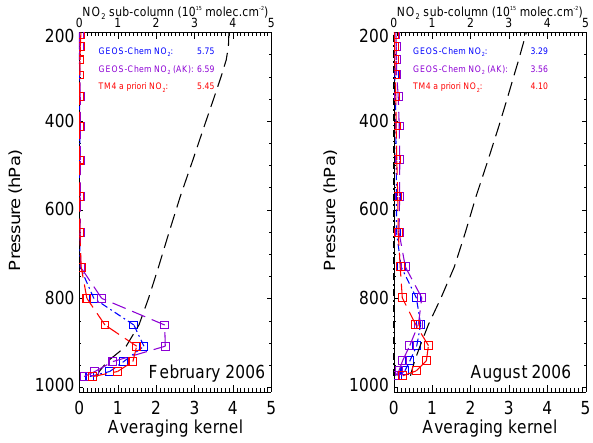
Figure 7. Monthly mean averaging kernel (black dashed line) and NO 2 profiles simulated by GEOS-Chem (blue), TM4 (red, a priori profiles in OMI NO 2 retrieval), and GEOS-Chem convolved with the averaging kernel (purple) following Eq. (6): left panel. Febru- ary 2006; right panel, August 2006 over the Beijing grid cell (cen- tred on 40 ◦ N, 116.25 ◦ E). The numbers given in blue, purple, and red indicate the tropospheric vertical NO 2 columns in GEOS-Chem and